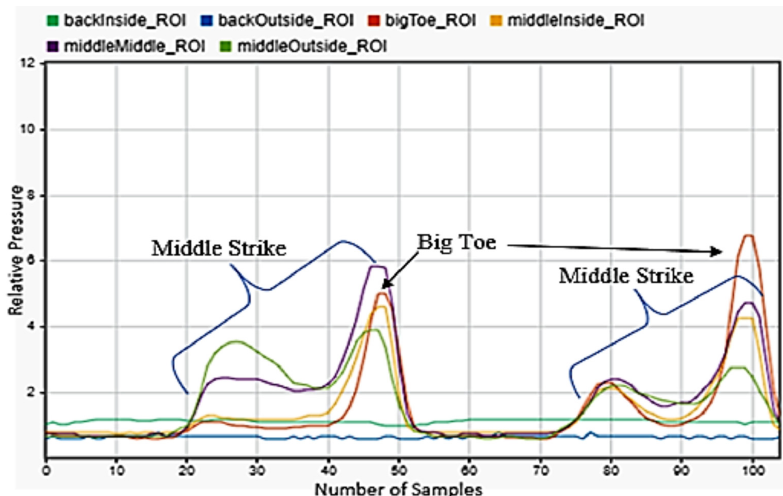
Sensors 2022 , 22 , x FOR PEER REVIEW